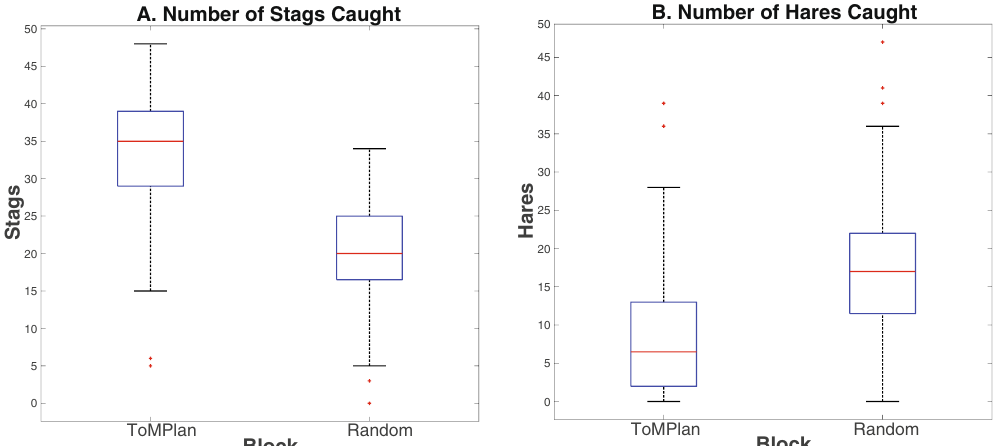
Figure 3. Hunting behavior by subjects playing the Stag Hunt. ( A ) Number of stags caught over all games by block. Subjects caught significantly more stags ToMPlan condition (p < 0.001). ( B ) Number of hares caught by subjects over all games by block. Subjects caught significantly more hares in the Random condition (p < 0.001). In the graphs, the x-axis is blocked by agent type, while the y-axis is total stags caught during block ( A) and total hares caught by subject during block, out of a maximum of 50 ( B